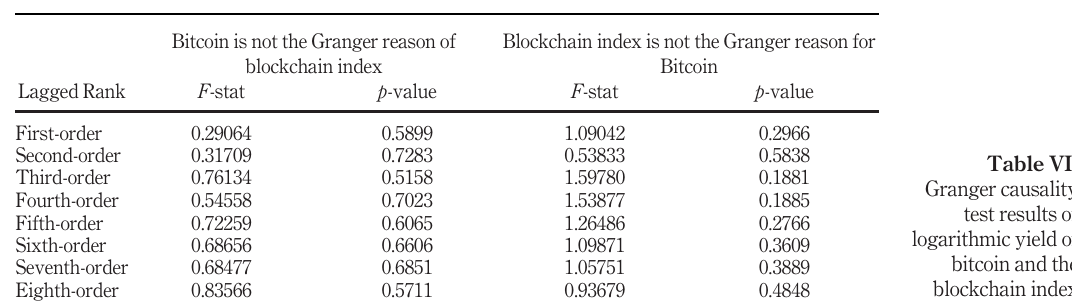
Table V. ADF Test results of